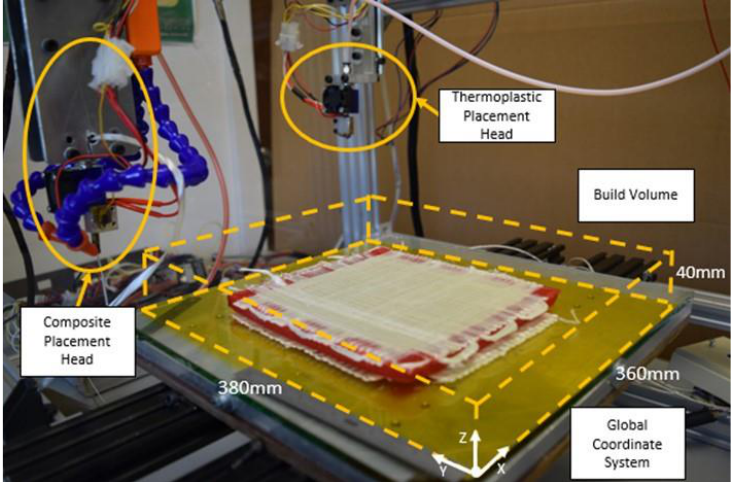
Figure 3. Dual gantry automation platform.